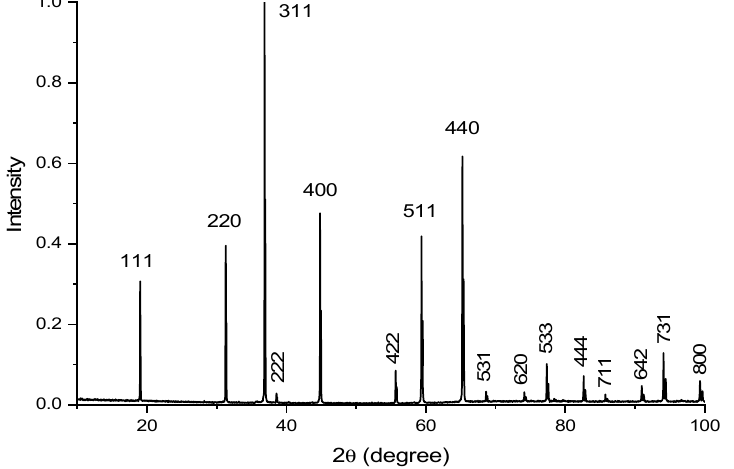
Figure 1. X-ray diffraction pattern of the MgAl 2 O 4 spinel doped with 0.2 mol% MnO 2 (sample I). The labels on the peaks are the Miller indices of the corresponding lattice planes.